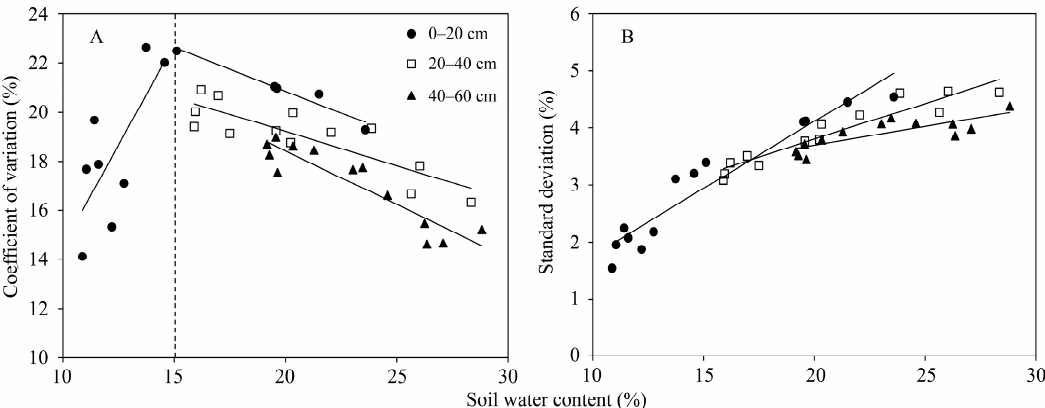
Figure 4. The relationships between the slope mean VSM and the coefficient of variation ( A ), and the standard deviation ( B ).